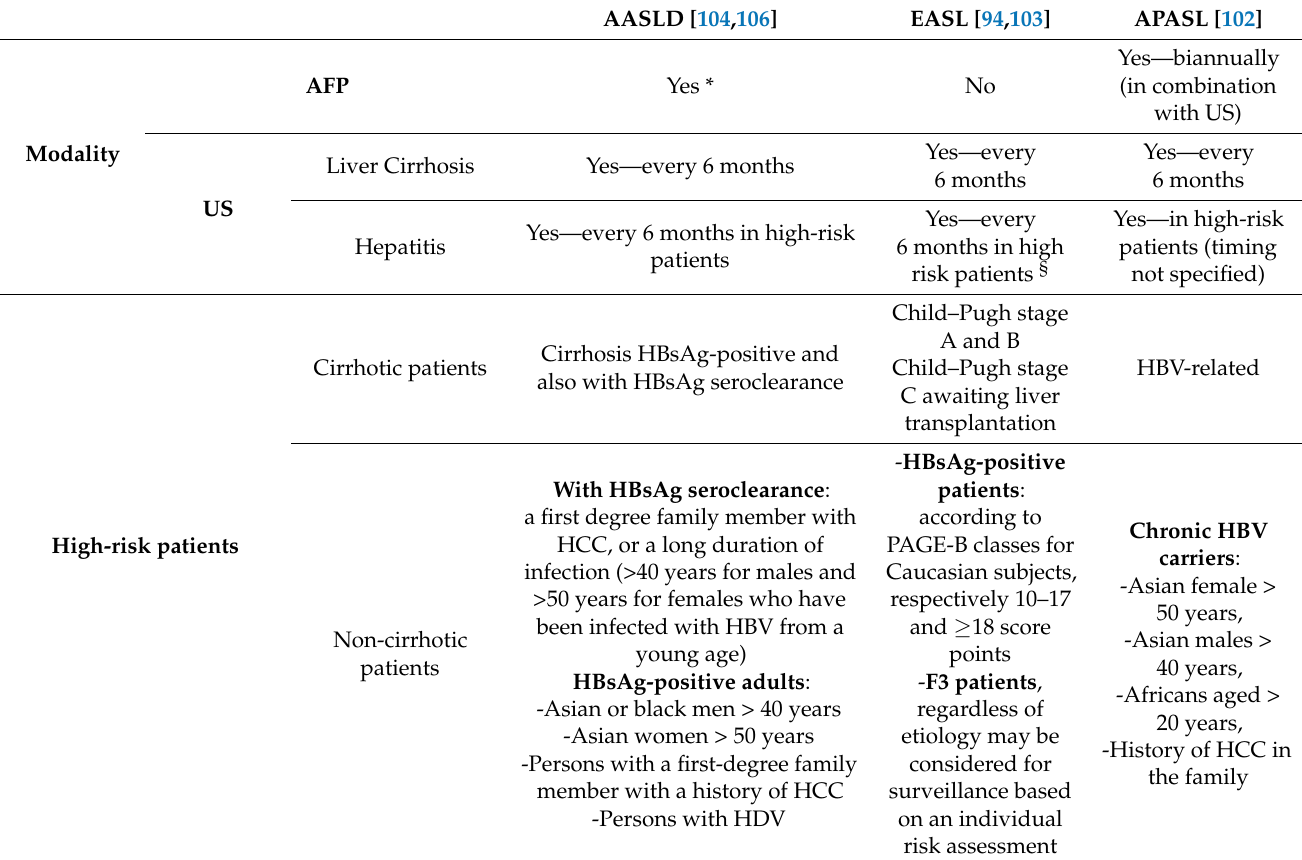
Table 1. Differences regarding surveillance among the major